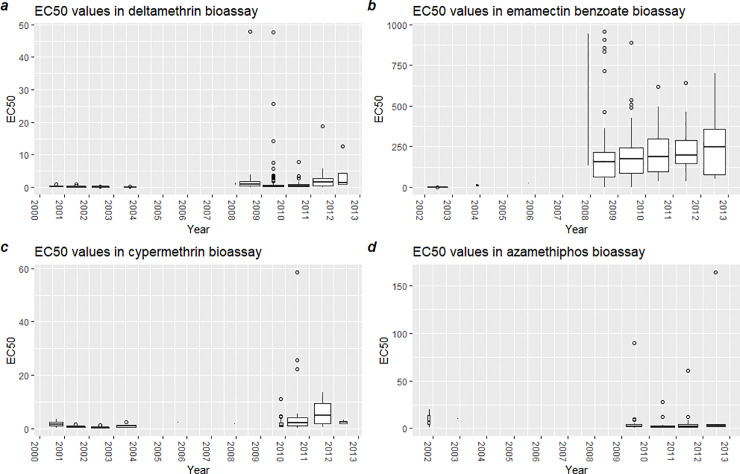
Predicted EC50 values in bioassays run in years 2000–2012.